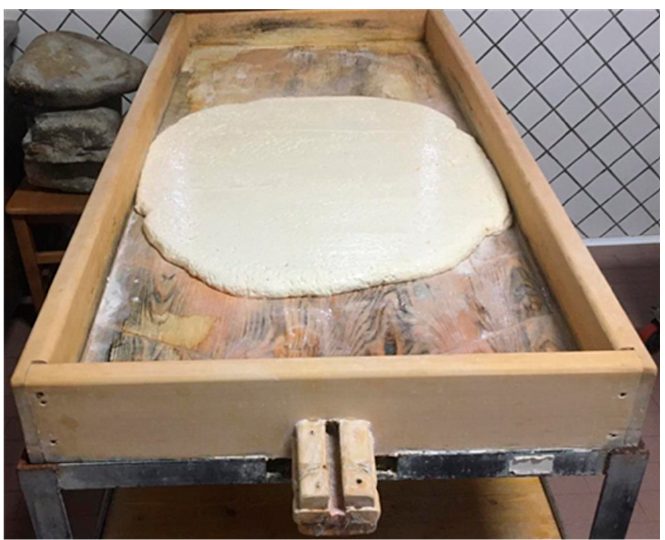
Figure 1. “Mastredda”, a wooden table used for curd acidification during PDO Provola dei Nebrodi cheese production.